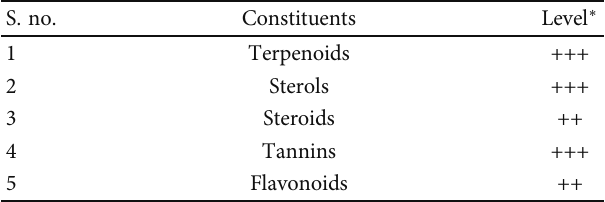
Table 1: Phytochemical screening of C. myrrha extract. S. no.